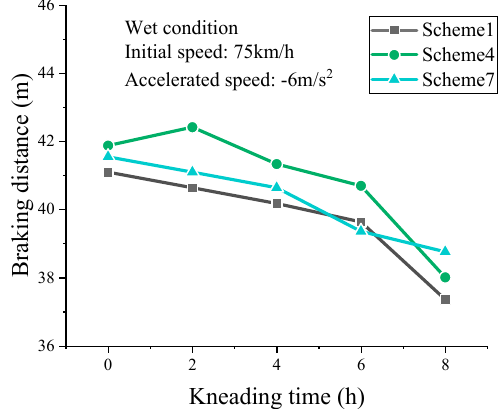
Figure 15. Results for braking distance in wet